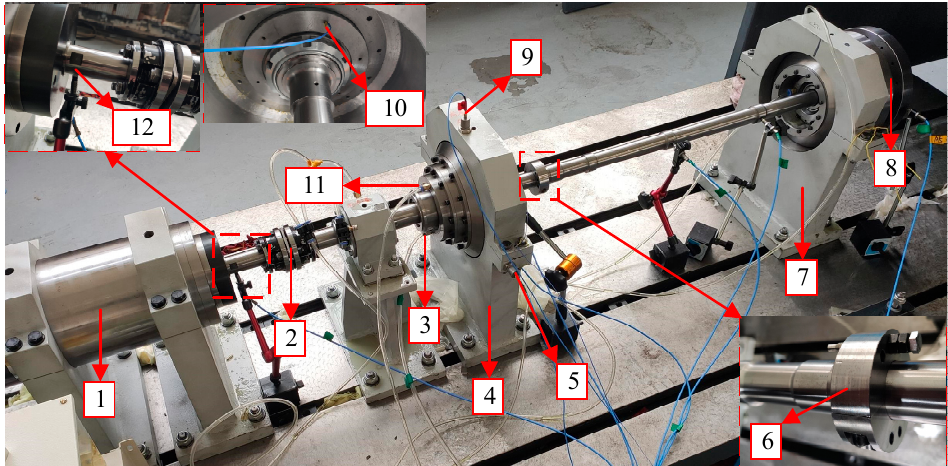
Figure 1. Test rig of the rolling bearing-rotor system and sensors lay out (1-motorized spindle, 2-coupling, 3-forced lubrication inlet, 4-housing containing test bearing, 5-accelerometer in the hori- zontal direction, 6-disc with unbalance, 7-housing containing support bearing, 8-disc, 9-accelerometer in the vertical direction, 10-thermocouple, 11-forced lubrication outlet, 12-tachometer).